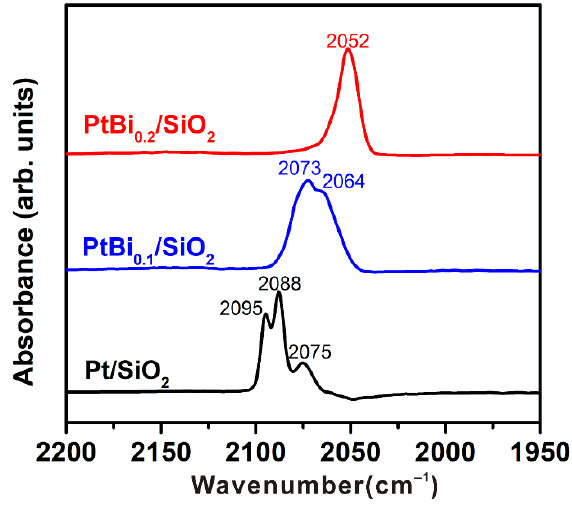
Figure 5. IR spectra of catalysts with pre-adsorbed CO.